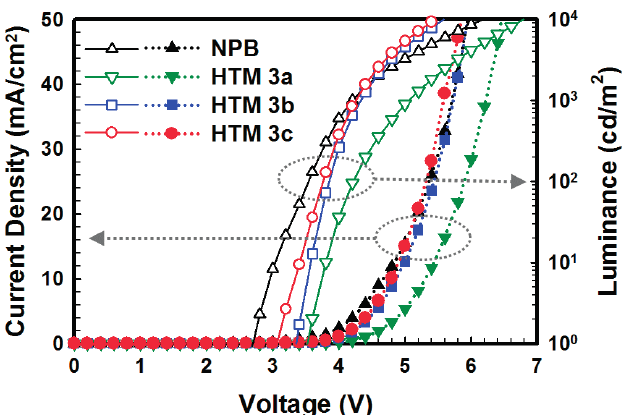
Figure 3. J-V-L characteristics of fabricated